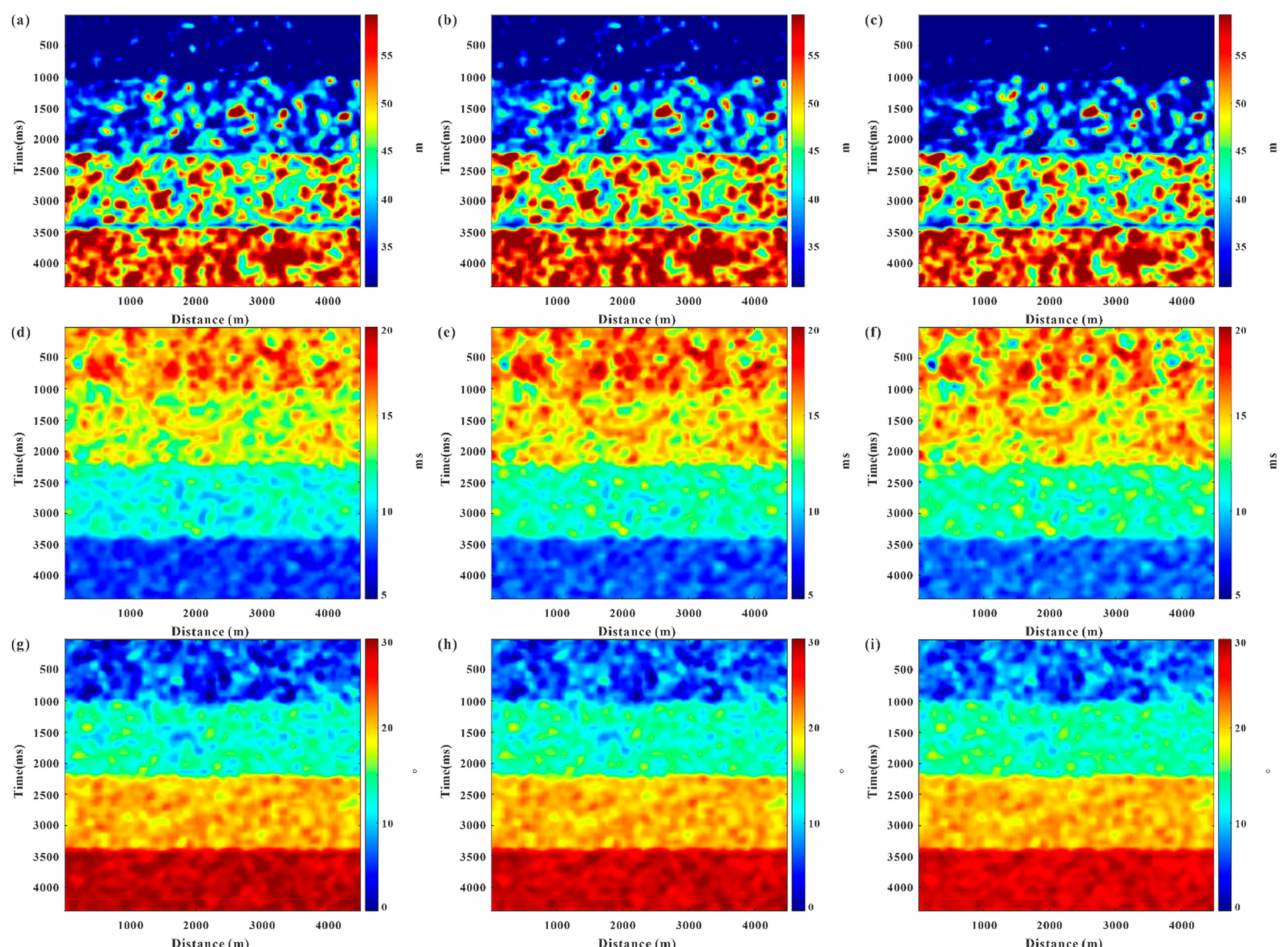
Figure 8. Estimation results of autocorrelation parameters of porosity, clay volume, and water saturation: ( a – c ) are the horizontal autocorrelation length of porosity, clay volume, and water saturation, respectively. ( d – f ) are the vertical autocorrelation length of porosity, clay volume, and water saturation, respectively. ( g – i ) are the autocorrelation angle of porosity, clay volume, and water saturation,